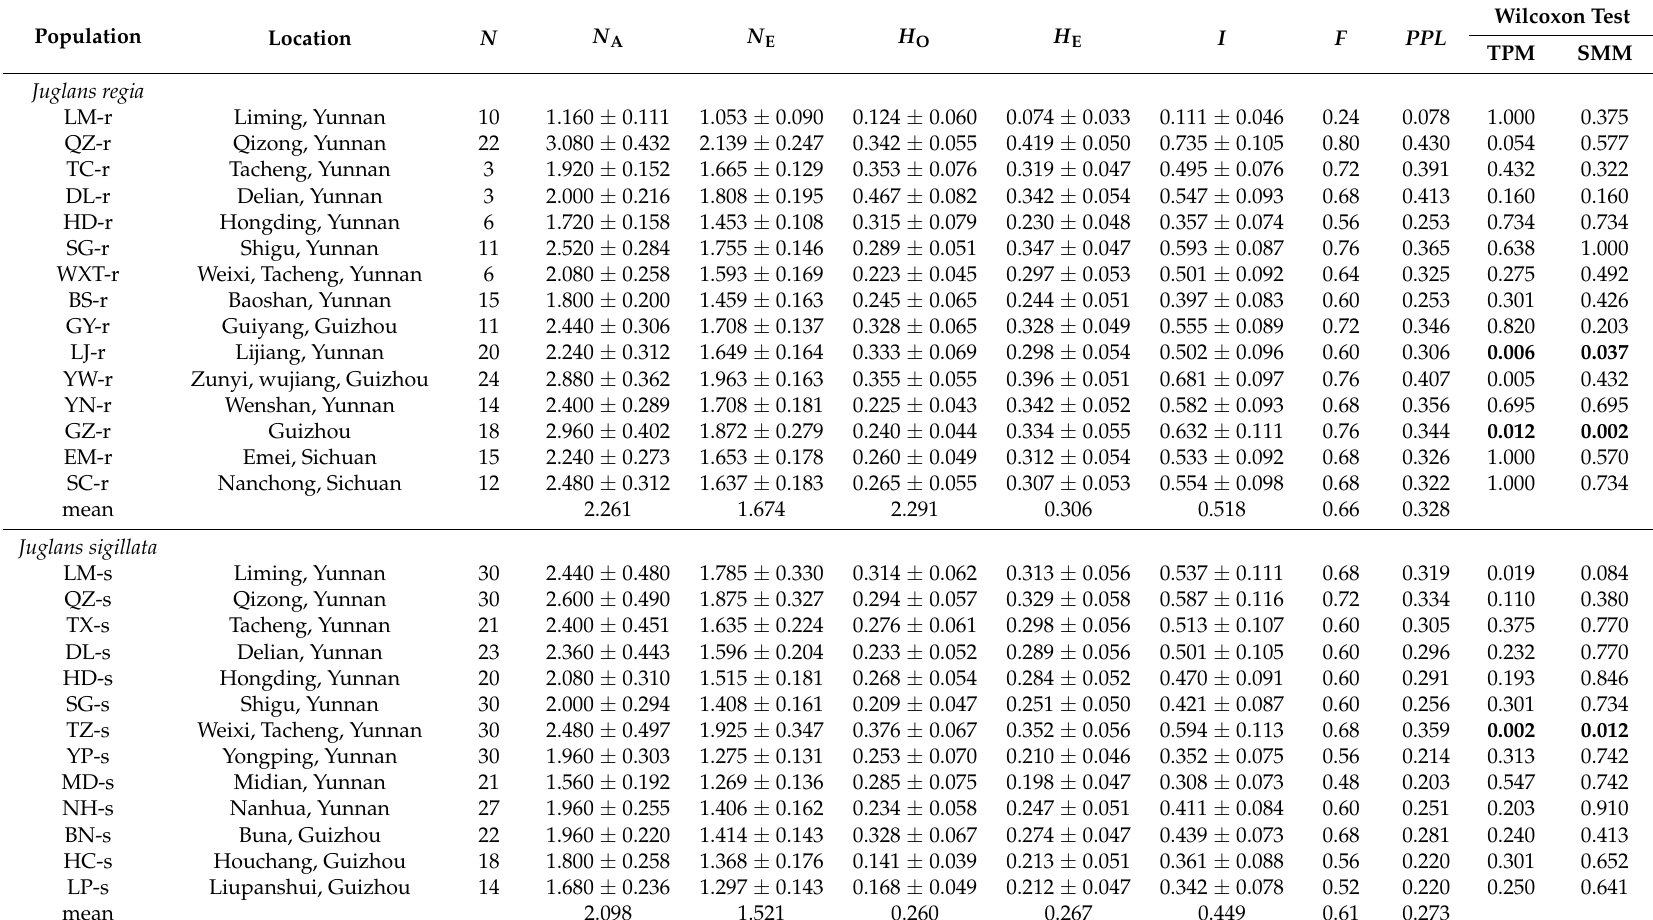
Table 2. Genetic diversity of 28 Juglans populations based on 25 EST-SSR